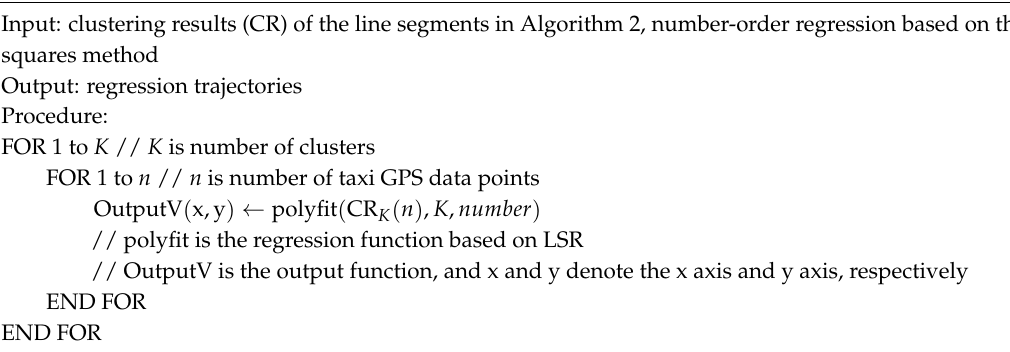
Algorithm 3. LSR-based regression for clustering results from Algorithm